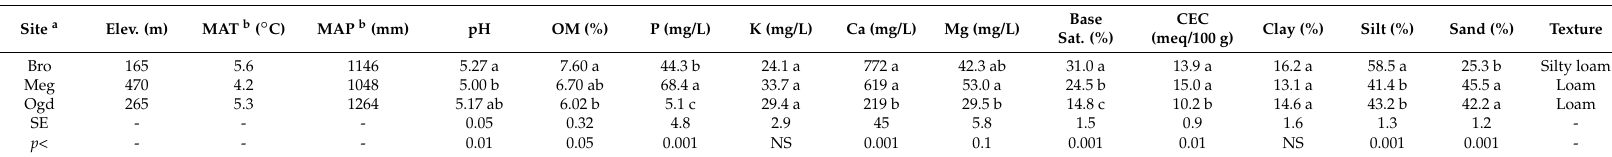
Table 1. Site and soil characteristics at the three plantation sites. Site-level characteristics identified with different letters are significantly different ( α = 0.05; Tukey’s honest significant difference